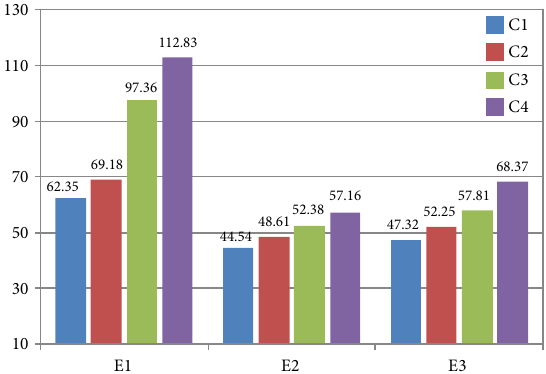
Fig. 4. Comparisons of three evaluation indexes in different